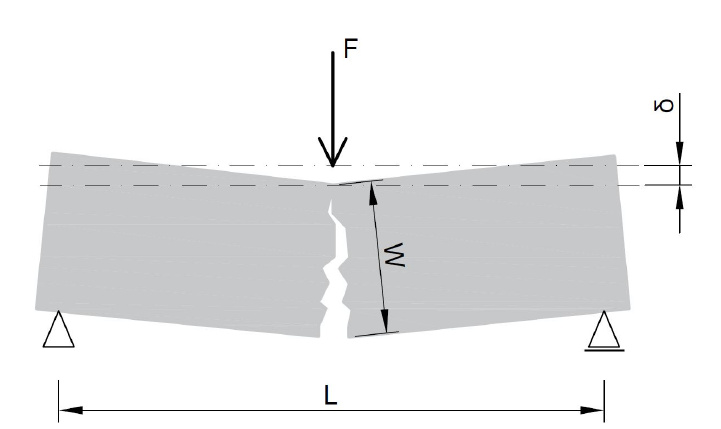
Figure 6. Schema of the three-point bending test.